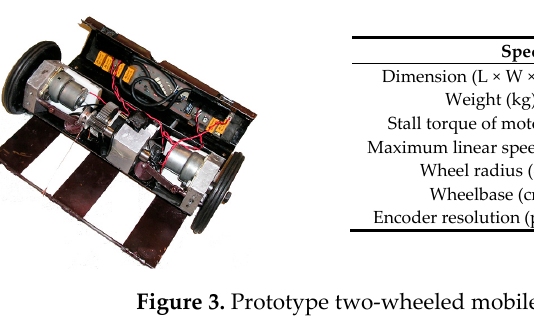
Figure 3. Prototype two-wheeled mobile